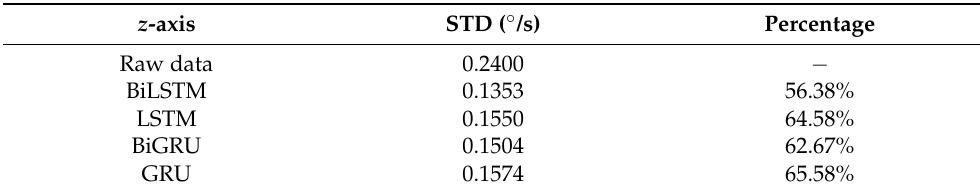
Table 7. Comparison of raw data, BiLSTM, LSTM, BiGRU, and GRU standard deviation values for z -axis